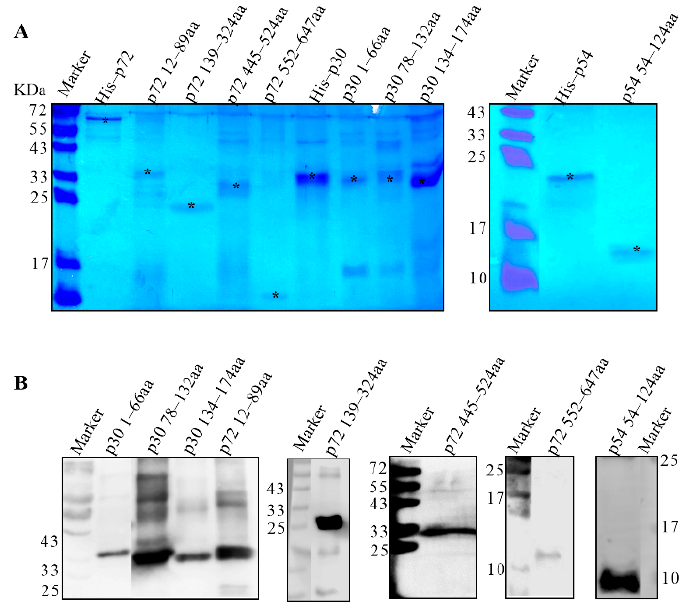
Figure 4. Identification of truncated proteins. ( A ) Identification the expression of truncated proteins by SDS–PAGE. The whole cellular proteins with induction were electrophoresed on 10–15% SDS– PAGE and visualized by coomassie brilliant blue G250 staining. The predicted molecular